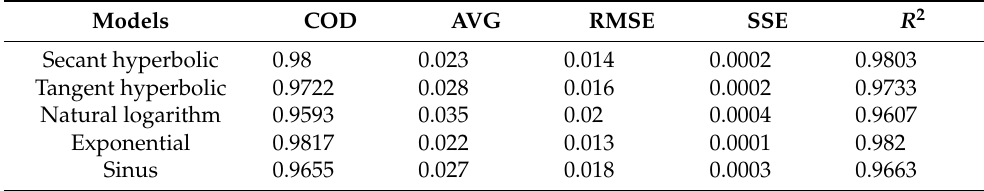
Table 9. Precision and performance of models for CSR prediction (testing data).